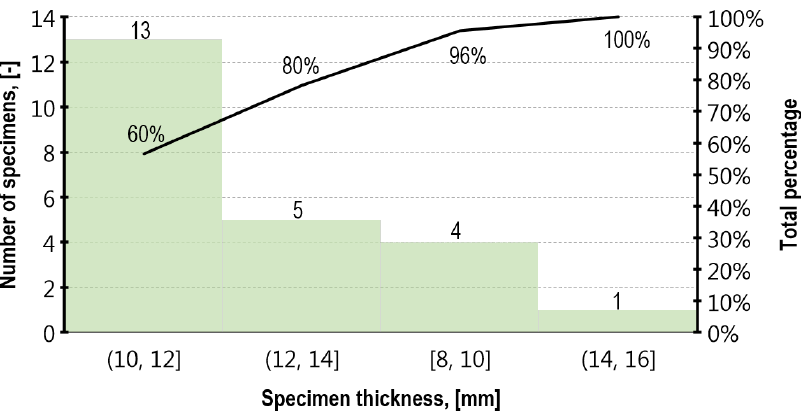
Figure 10. The percentage share of the respective DPT thickness values in the tested population after 90 weeks—no capping included. 90 weeks—no capping